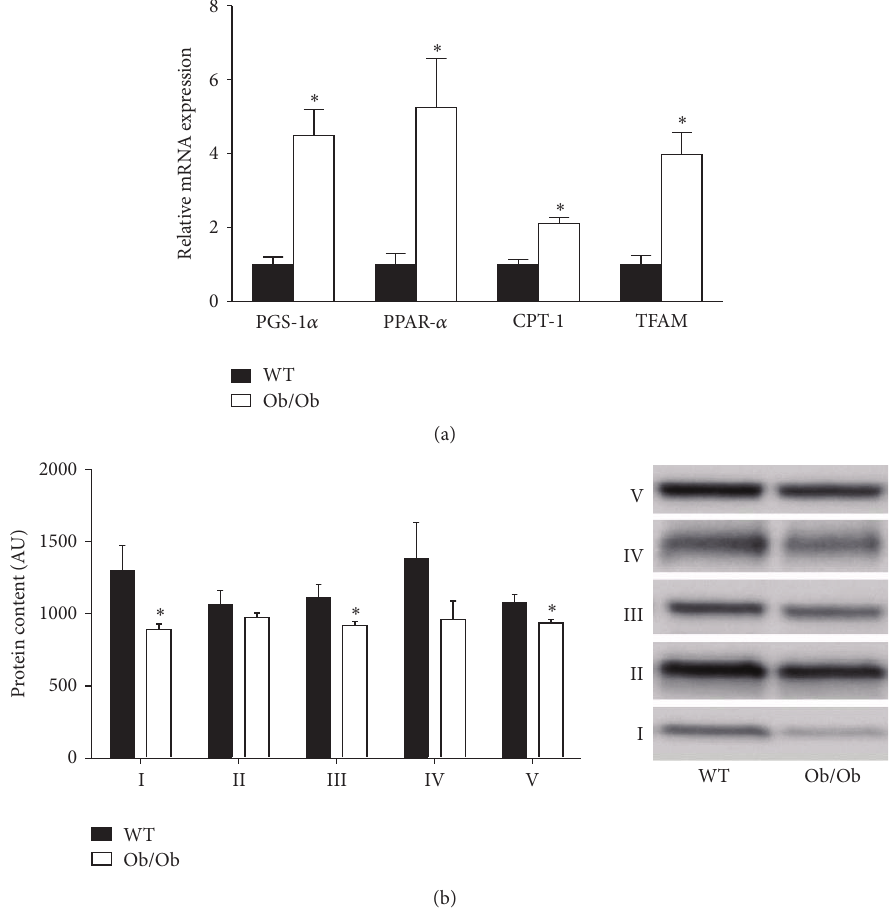
F 3: Markers of hepatic lipogenesis are elevated in Ob/Ob mice. Gene expression (a) and protein content (b) of hepatic lipogenesis markers were elevated in 14-week-old male Ob/Ob mice as compared to age-matched male wild-type (WT) mice. Values are means ( 𝑛𝑛 𝑛 𝑛